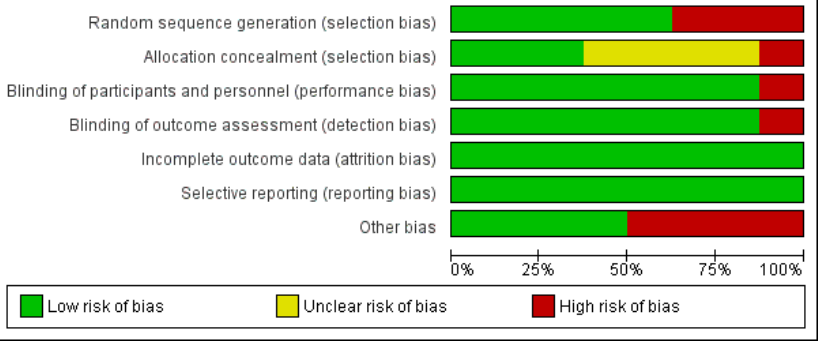
Figure 2. Risk of bias graph: review author's judgments about each risk of bias item presented as percentages across all included studies.